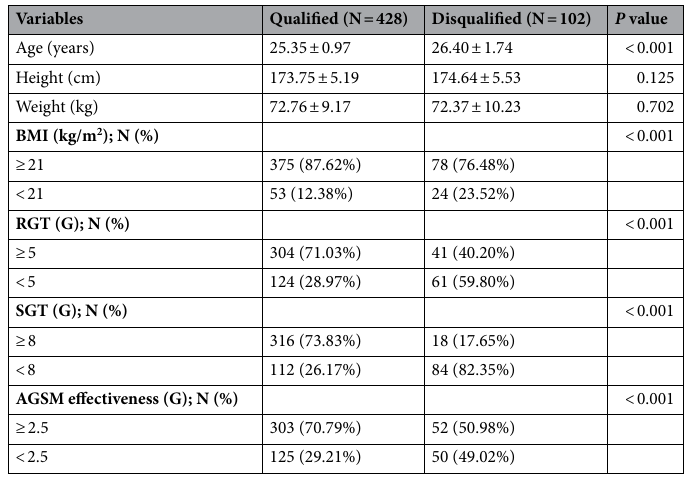
Table 1. Characteristics of the 9G profile training attempts. N number, BMI body mass index, RGT relaxed G tolerance, SGT straining G tolerance, AGSM anti-G straining manoeuvre.